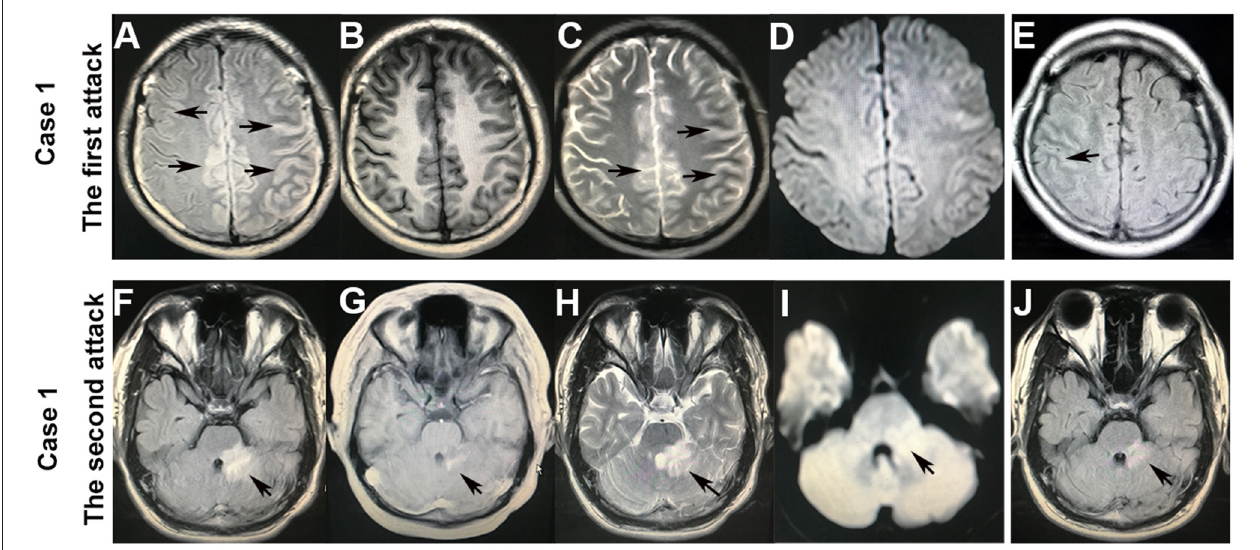
FIGURE 1 | Brain MRI of case 1. After the first attack of an epileptic seizure, the hyperintense lesions with a hazy border in the bilateral cortex on fluid-attenuated inversion recovery (FLAIR) (A) and T2-weighted (C) images (arrowheads), which were less evident on T1-weighted (B) and diffusion-weighted (D) images. FLAIR hyperintensities in the cortical regions became shallow and fewer after 3 months (E) (arrowheads). After the second attack that presented with dizziness and left-sided ataxia, the hyperintensities in the pons and left brachium pontis on FLAIR (F) , T1-weighted (G) , T2-weighted (H) , and diffusion-weighted (I) images (arrowheads). The FLAIR hyperintensities in the brainstem became shallow and smaller after 1 month (J) .